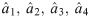
Identification of unknown parameters of systems (12) and (25).(a) a^1, a^2, a^3, a^4 ; (b) d^1, d^2, d^3, d^4 .